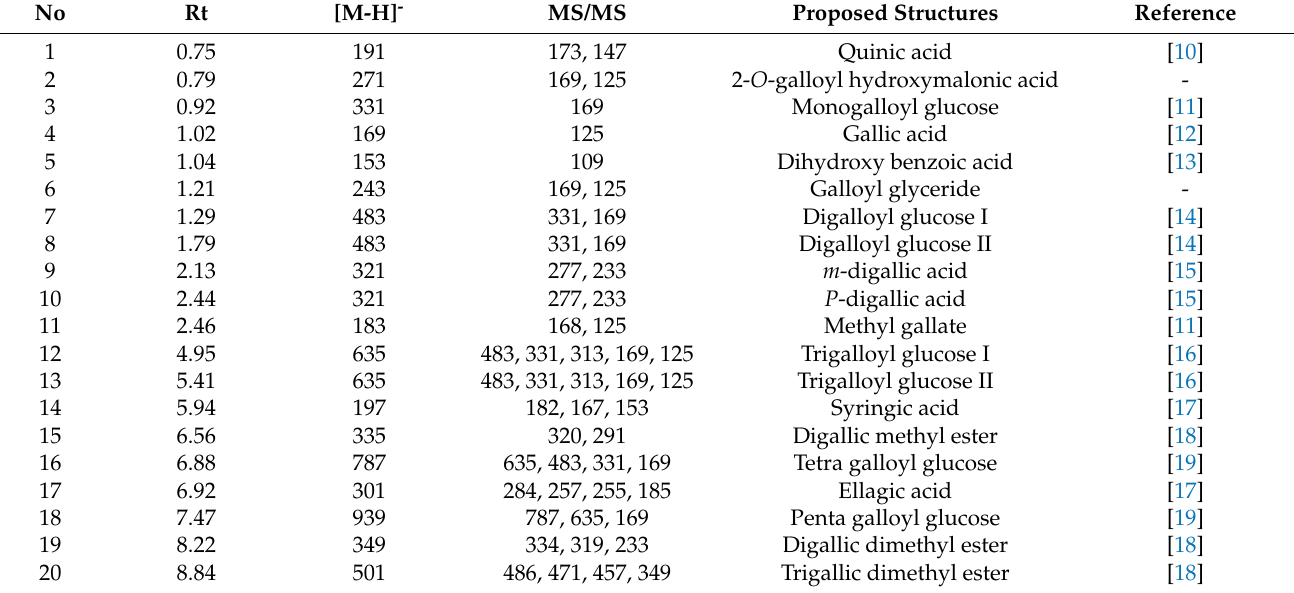
Table 1. LC-MS/MS analysis of phenolic metabolites from Q. infectoria galls ethanol